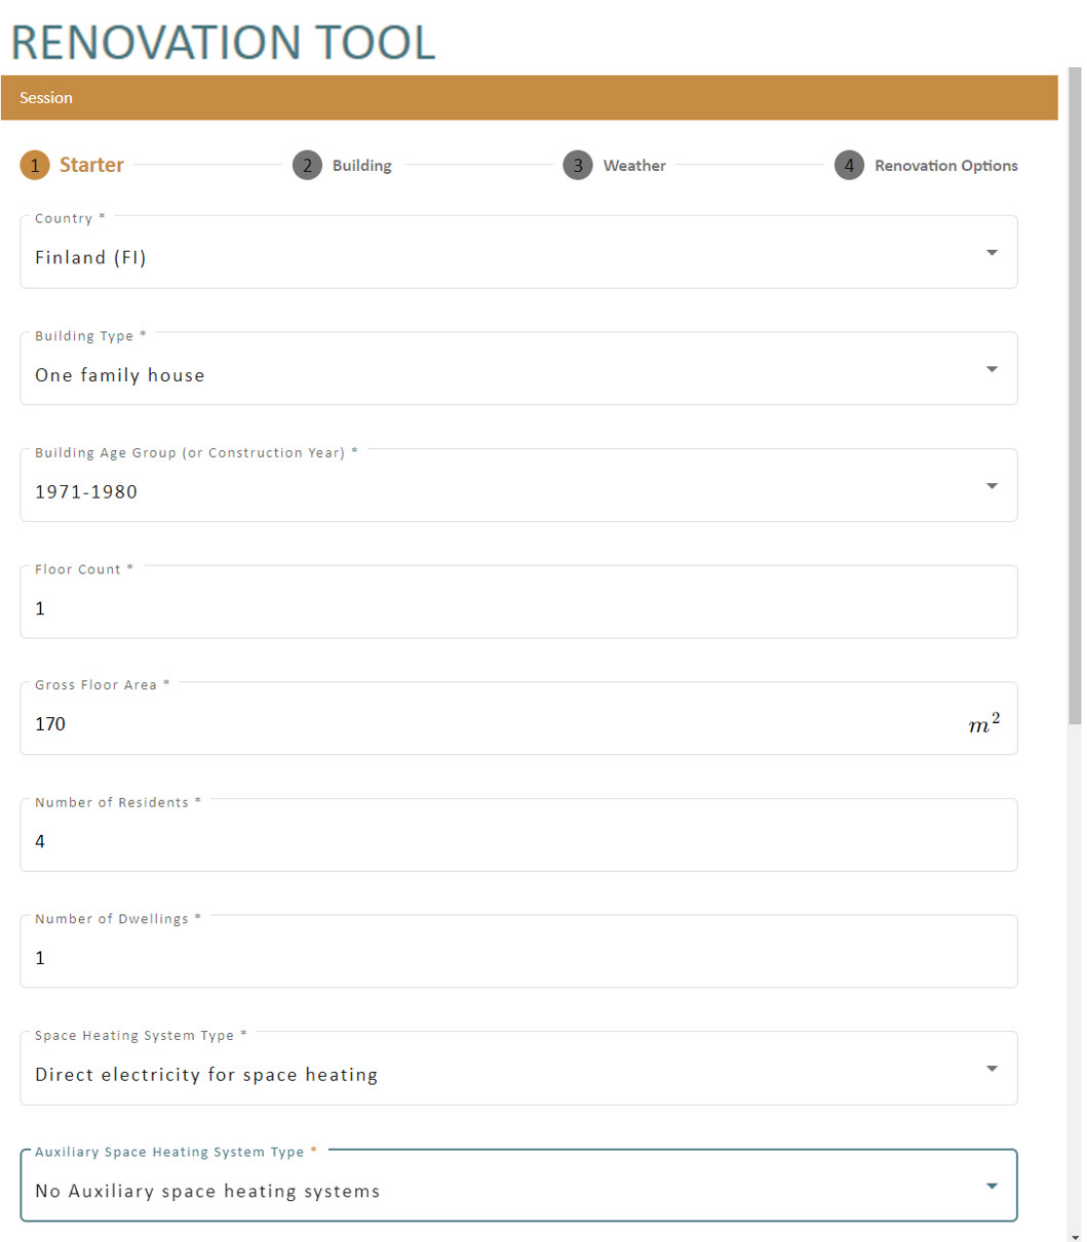
Figure 5. Retrofitting tool GUI, part of step 1.